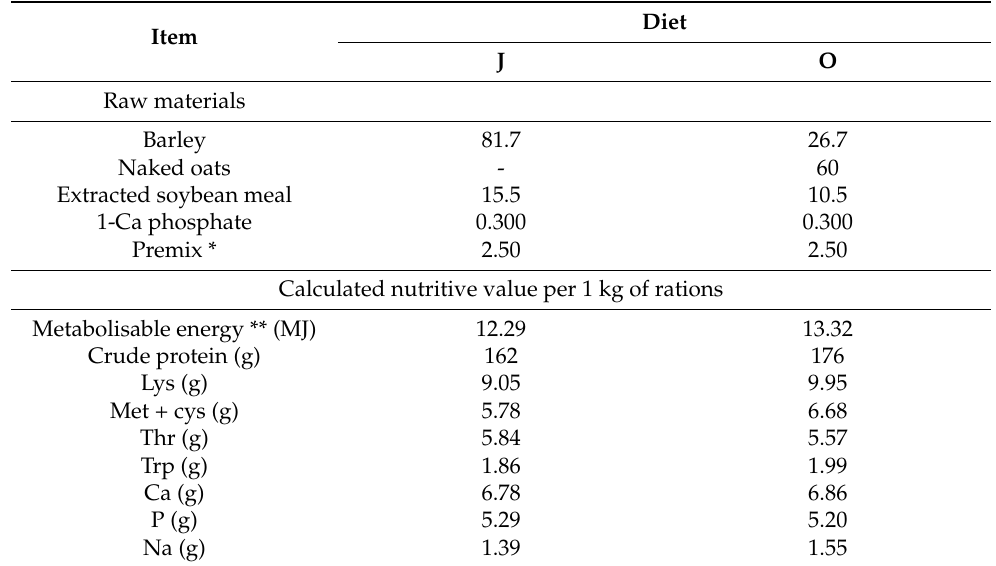
Table 1. Raw materials (%) and nutritive value of diets. Item